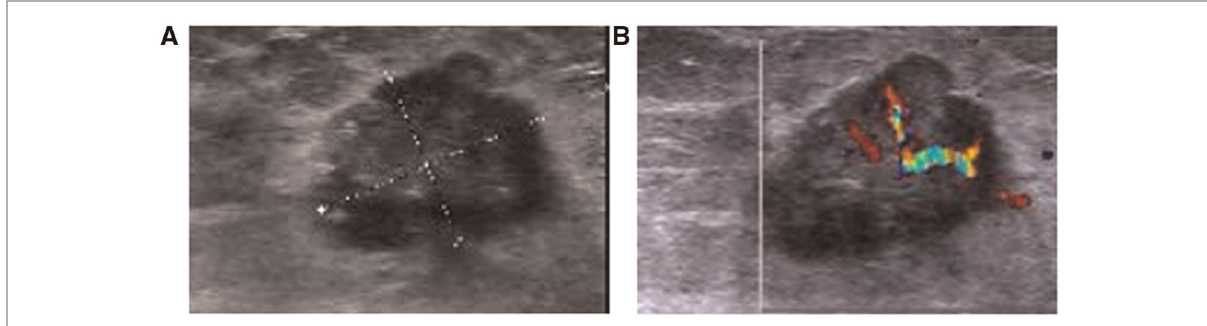
FIGURE 2 Breast sonography from a 42-year-old woman with a suspicious breast mass ( A ) the breast sonography shows a hypoechoic mass in the left breast, located 1 cm away from the nipple in the 6 O ’ clock direction, with a spiculated margin, irregular shape, and crab foot sign. ( B ) Color Doppler sonography shows the presence of large blood vessels in the tumor, with obvious arterial blood fl ow signals.